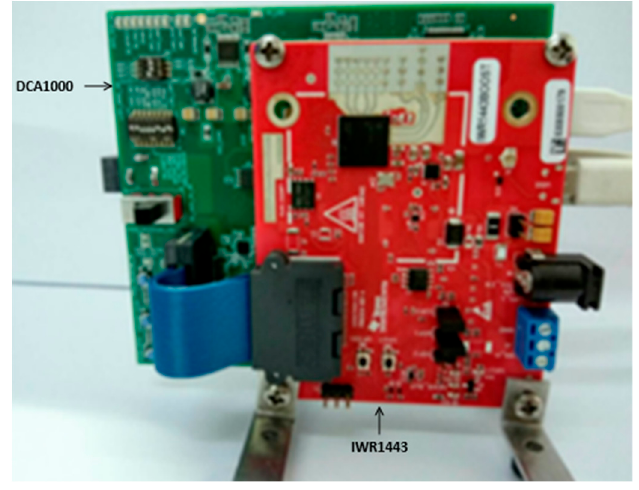
Figure 9. Radar signal data acquisition module. Table 1. Parameters Configuration of frequency modulated continuous wave (FMCW) radar.